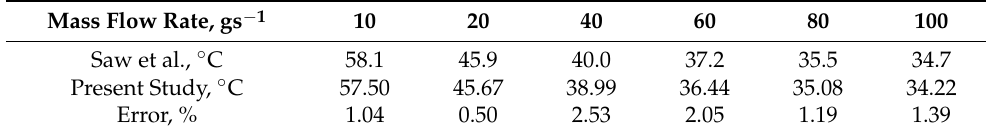
Table 5. Comparison of battery temperature without AFHS [35].